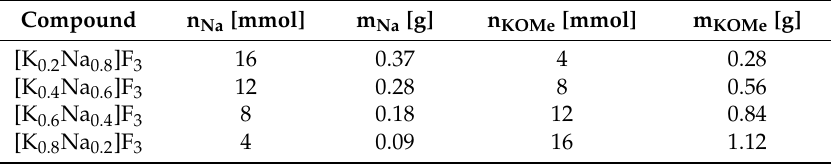
Table 2. Amounts of reactants in [K (1 − x ) Na x ]MgF 3 syntheses. Compound n Na [mmol]